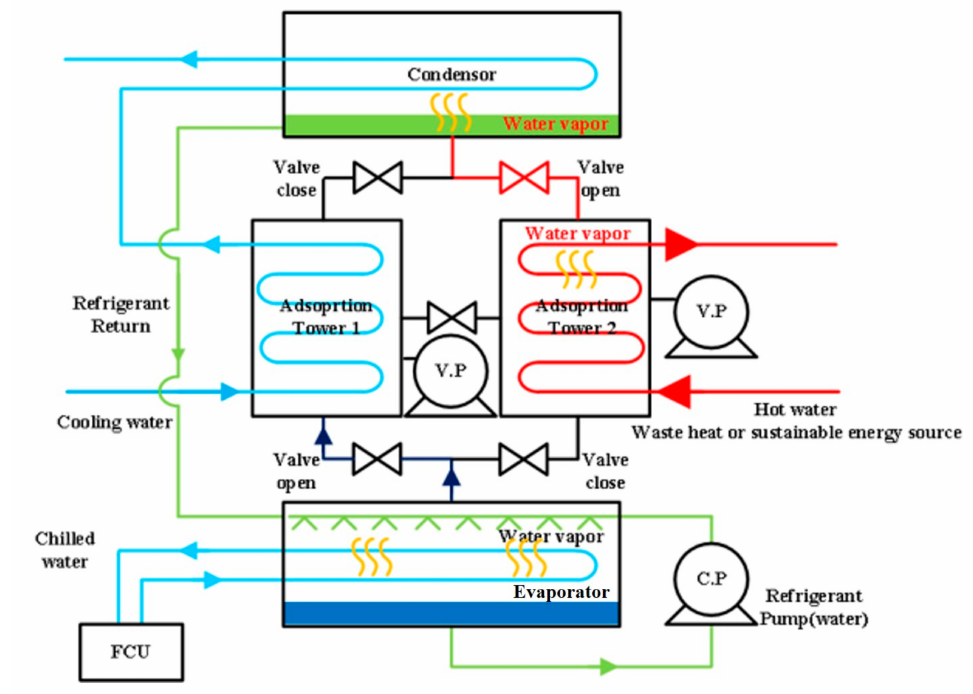
Figure 3. Schematic diagram of an AD